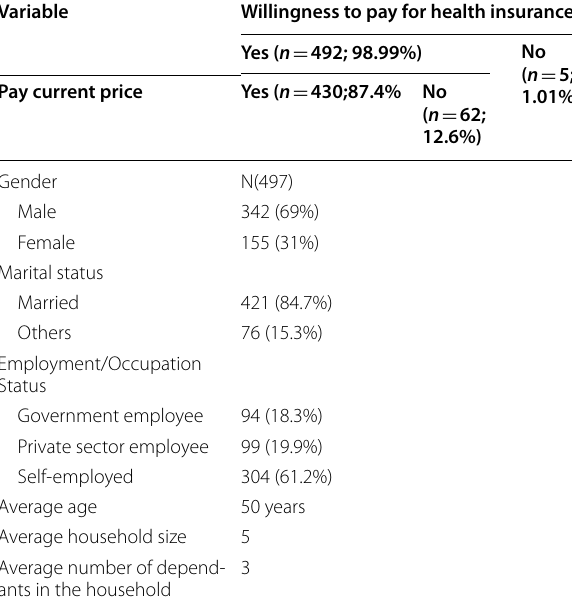
Table 1 Descriptive findings Table 2 Convergent validity and collinearity